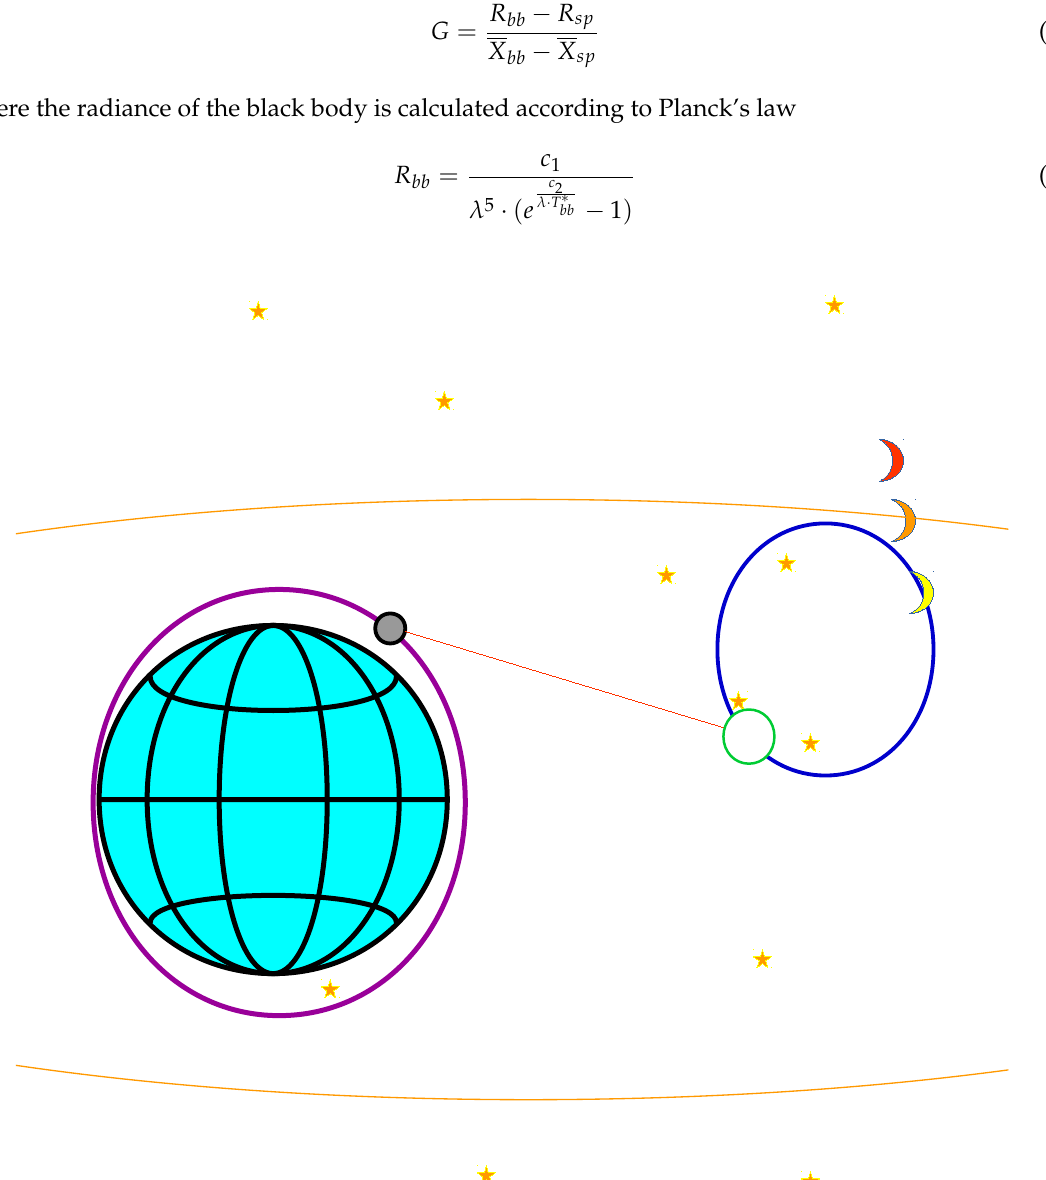
Figure 2. The pointing direction of the DSV describes a circle (blue) in the sky during one orbit of the satellite. When the position of the Moon on its orbit around the Earth (orange) coincides with this circle, it will appear for a short while in the FoV of HIRS. The orbit of the Moon is tilted against the celestial equator, so its minimum distance from the line of sight (straight red line) of the DSV of an instrument on a polar, sun-synchronous orbit (violet) is different each month. The orange position corresponds to a case, where part of the Moon stays outside the FoV, the yellow position corresponds to a case, where HIRS gets the radiation of the complete lunar disk. During that time the signal remains